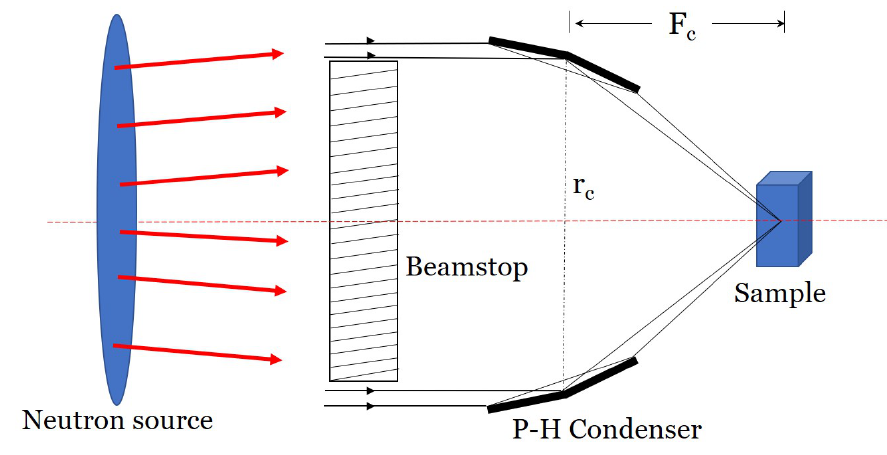
Figure 2. Schematic of the guide condenser system of a neutron microscope. The condenser is placed between the guide and the sample. P-H, paraboloid and